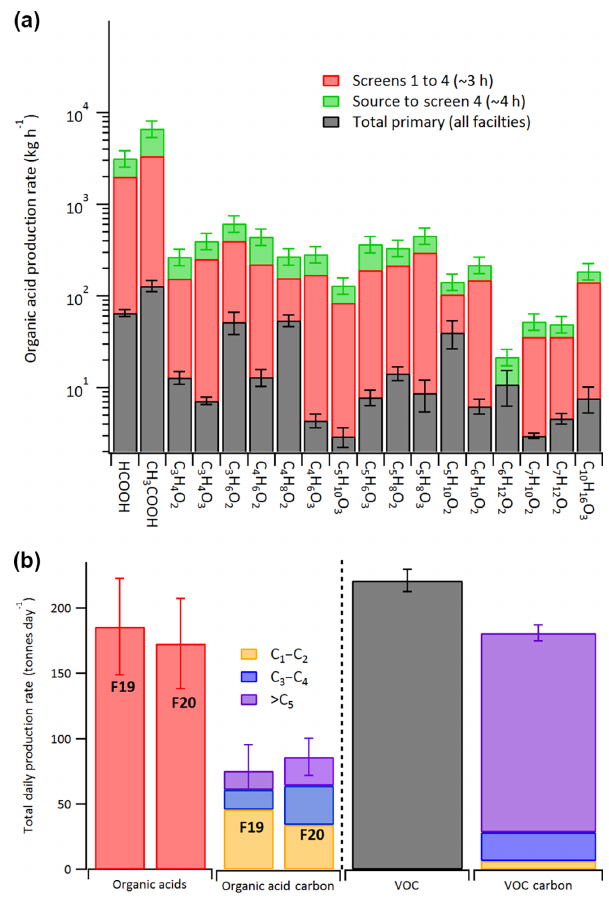
Figure 7. (a) Secondary LMWOA production rates (kilograms per hour) derived between screens 1 and 4 of F19 using the TERRA al- gorithm, and at screen 4 after removing the primary LMWOA con- tribution (green bars). The primary LMWOA emission rates are also shown (grey bars). (b) Total LMWOA secondary production rates (F19 and F20 neglecting deposition) extrapolated to 1 photochem- ical day compared to total reported primary VOC emissions and carbon associated with these VOC emissions (Li et al., 2017). Data for organic acid and VOC carbon are